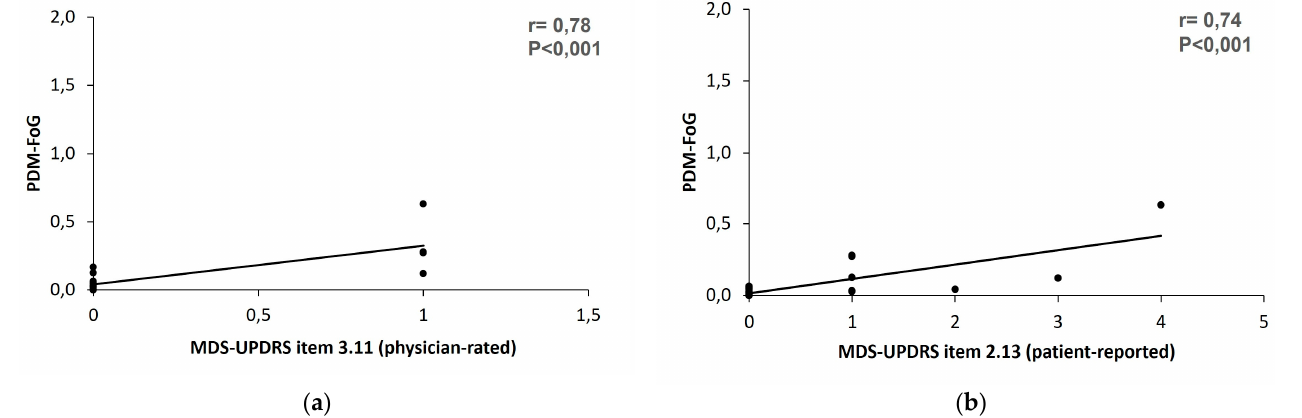
Figure 7. The correlation between the PDMonitor ® and MDS-UPDRS on the FoG ( a ) device score and physician-rated item 3.11 and ( b ) device score and patient-reported item 2.13. Hence, a strong to very strong correlation was identified on detecting symptom harshness and FoG events, respectively.